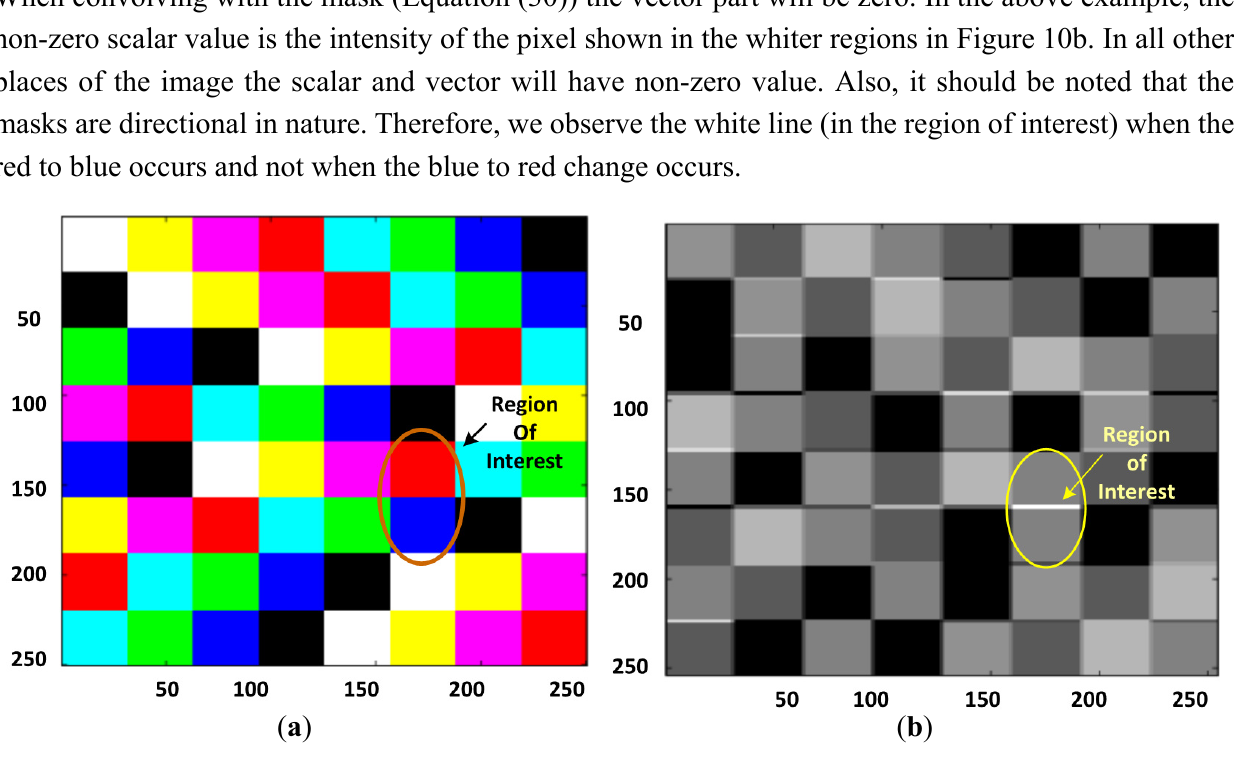
Figure 10. ( a ) Block Image and ( b ) After Step filtering.